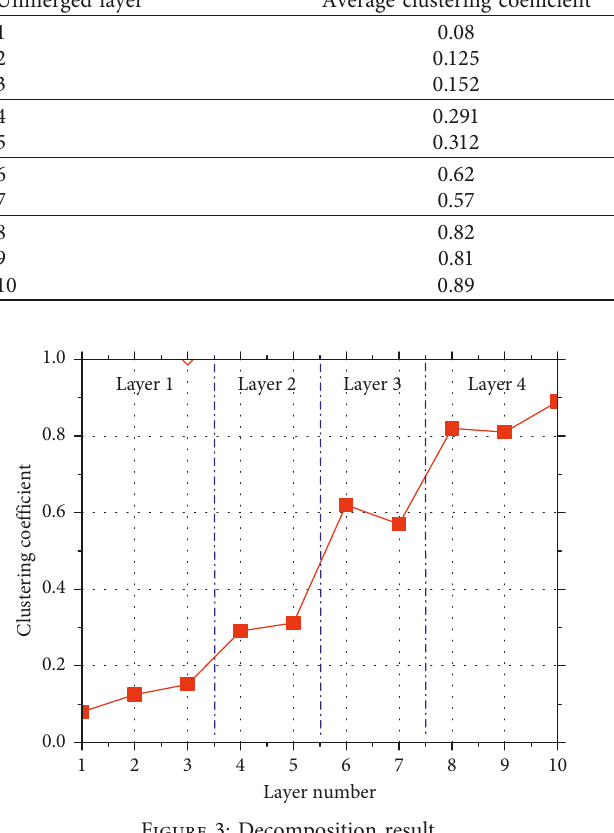
Figure 3: Decomposition